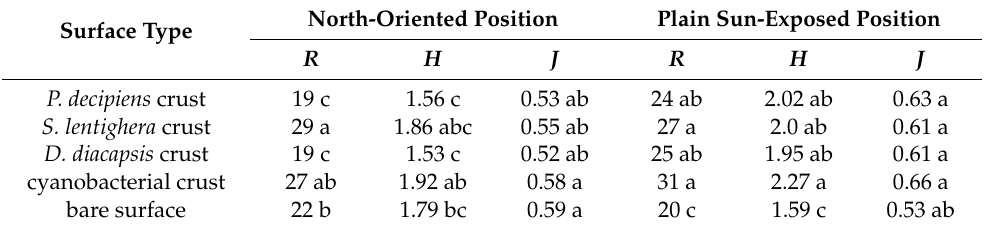
Table 2. Diversity characteristics of soil microfungal communities ( R —number of species, including sterile strains, H —Shannon index, J —evenness) in di ff erent crust types and bare surface at the Tabernas Desert. Means with the same letter are not significantly di ff erent (a one-way ANOVA, the Fisher test, at the 5% level).